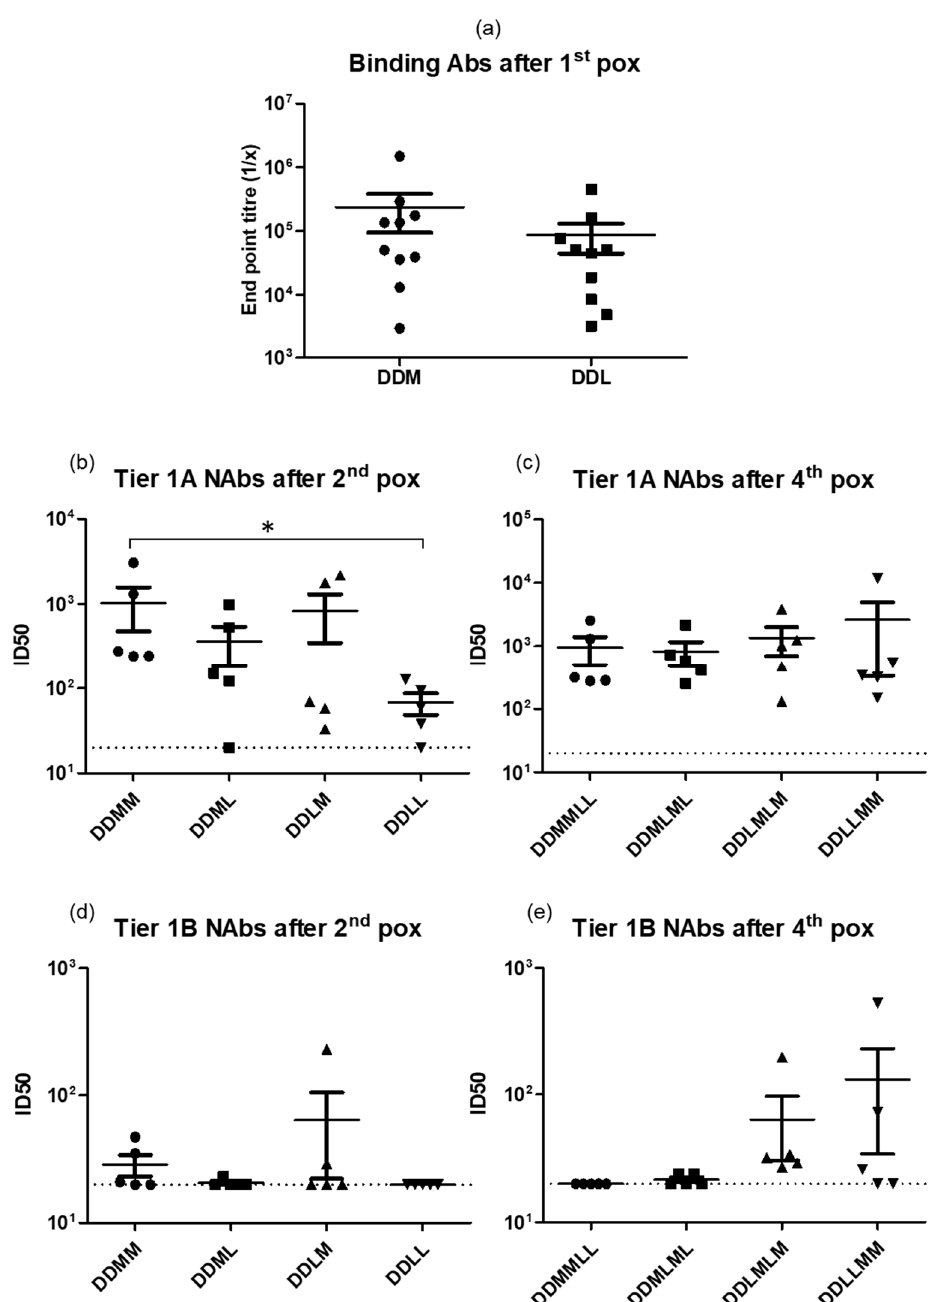
Figure 6. A comparison of antibody responses at different time points. ( a ) The binding antibody titers in rabbit sera after 2 DNA and a single poxvirus inoculation. Tier 1A and Tier 1B neutralizing antibody tires in rabbit sera after 2 DNA and 2 poxvirus inoculations (( b , d ) respectively), and after 2 DNA and 4 poxvirus inoculations (( c , e ) respectively). The dotted black line represents the assay detection limit (1/20 dilution). Data were plotted as the mean +/ − SEM. * p > 0.008.